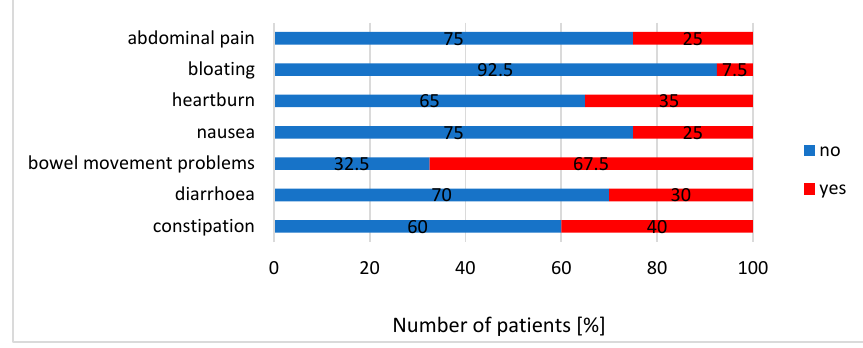
Figure 2. The summary of complaints reported by patients.